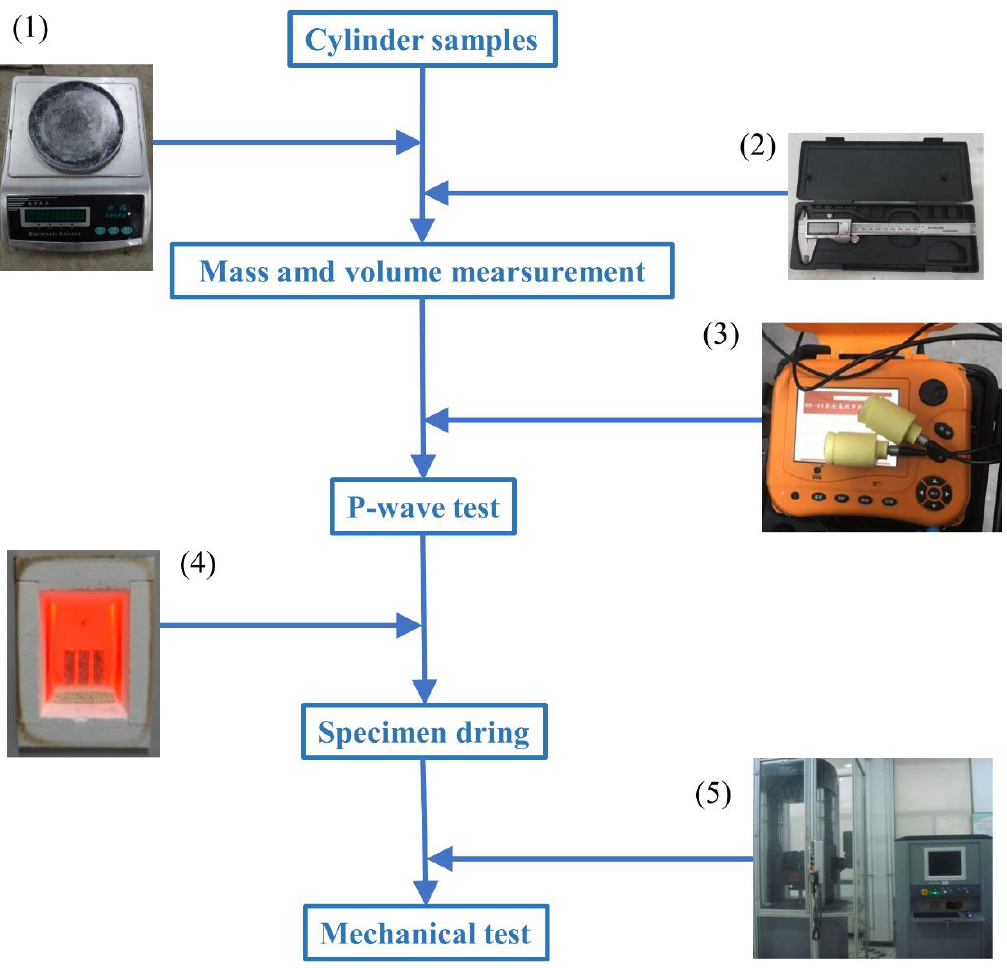
Figure 3. Experimental scheme and instructions: ( 1 ) mass measurement; ( 2 ) volume determination; ( 3 ) ultrasonic wave device; ( 4 ) heating oven; ( 5 ) mechanical test system.